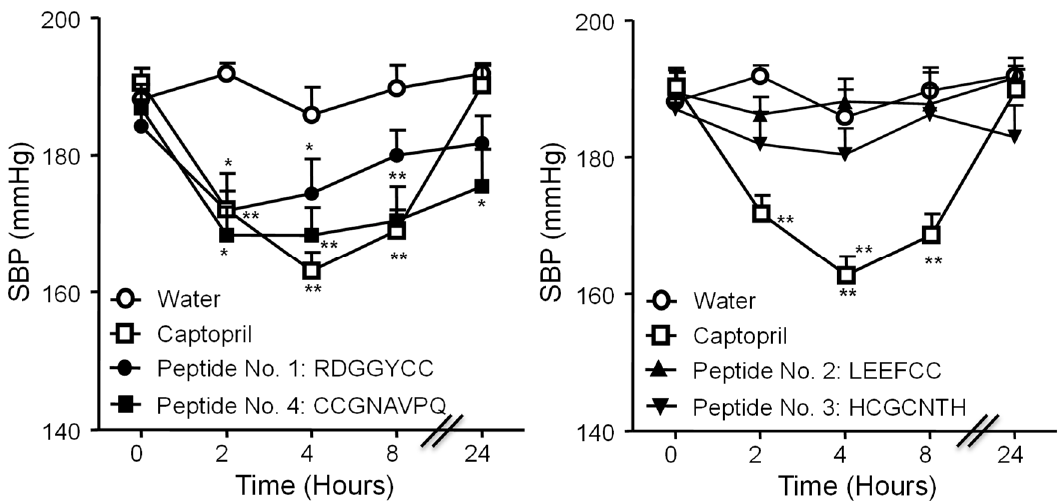
Figure 5. Systolic blood pressure (SBP) changes (mmHg) detected in spontaneously hypertensive rats (SHR) at baseline and 2, 4, 8 and 24 h after the administration of a 25 mg/kg BW dose of synthetic peptides No. 1 (RDGGYCC, ● ), No. 2 (LEEFCC, ▲ ), No.3 (HCGCNTH, ▼ ), No.4 (CCGNAVPQ, ■ ), Captopril (50 mg/kg of BW, □ ), or water control ( ○ ). * p < 0.05; ** p < 0.01 vs. control.